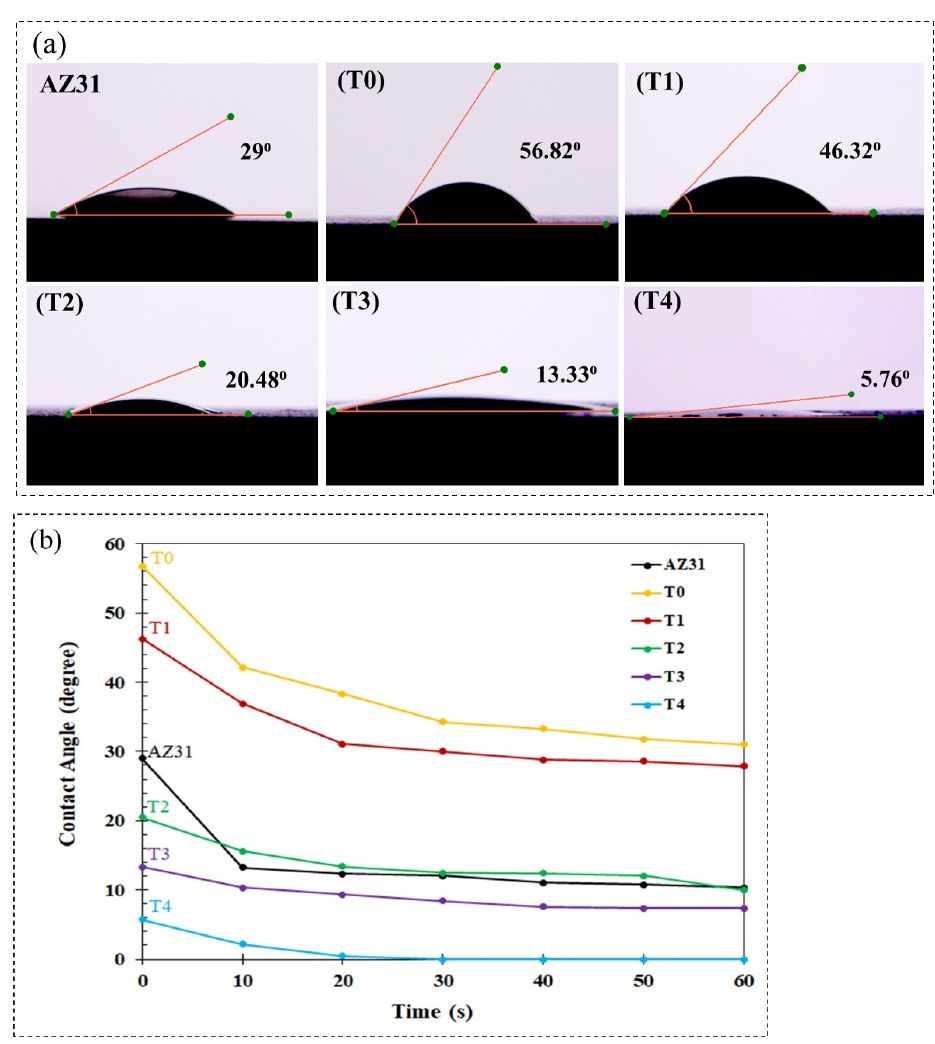
Figure 9. ( a ) Wettability graphs and ( b ) calculated contact-angle changes with time for PEO-coated specimens at various concentrations of TiO2: T0= 0 g/L, T1= 1 g/L, T2= 2 g/L, T3= 3 g/L, and T4= 4 g/L.